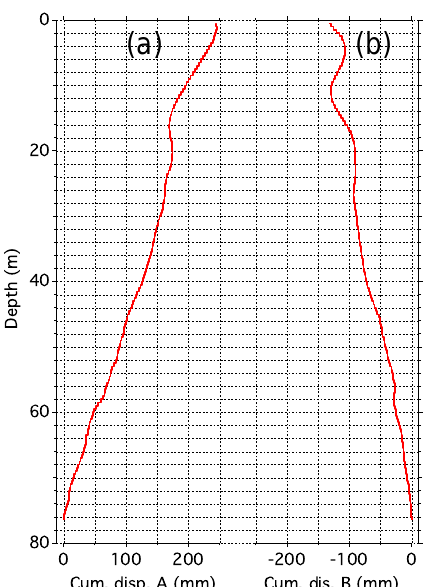
Figure 4. Relative cumulative displacement of borehole no. 2 along the two axes (A: 340 ◦ N; B: 70 ◦ N) during the 43 days after the end of the 2011 drilling operation. The cumulative displacement is relative as it uses the bottom portion of the inclinometer as a reference (not the